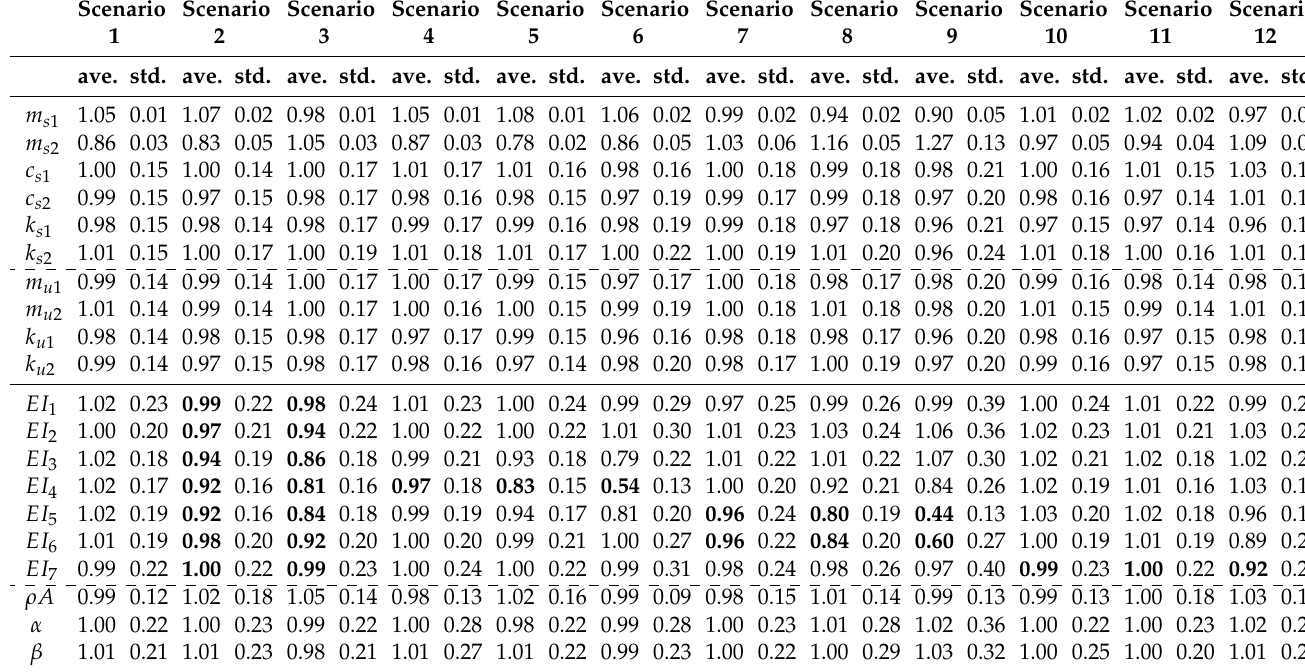
estimated EI i is shown in bold style, this indicates that the element i has reduced